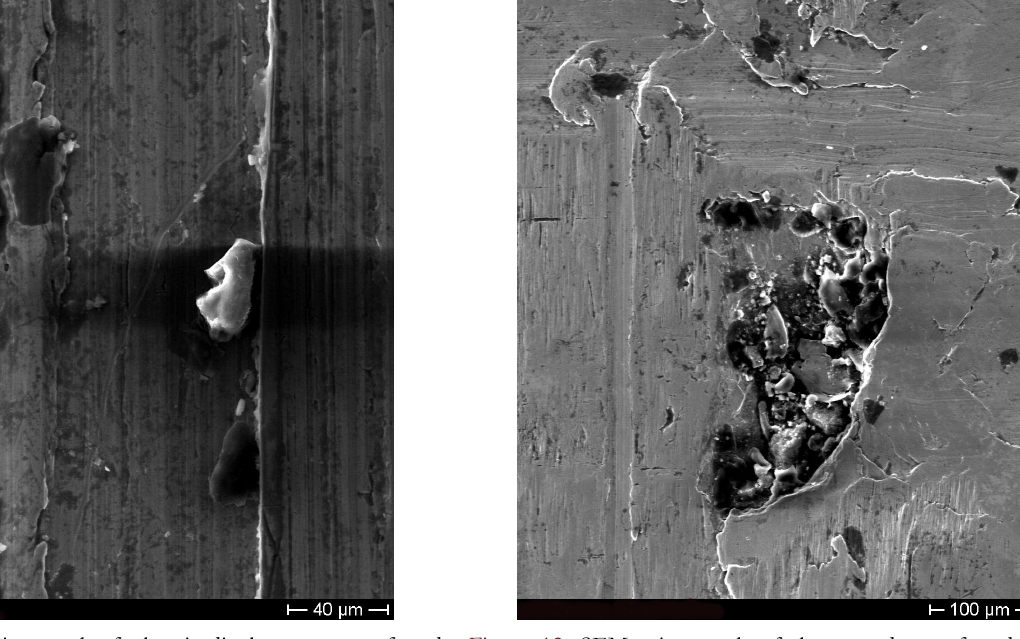
Figure 11: SEM micrograph of a longitudinal wear groove found in the central part of the piston (sample 1).